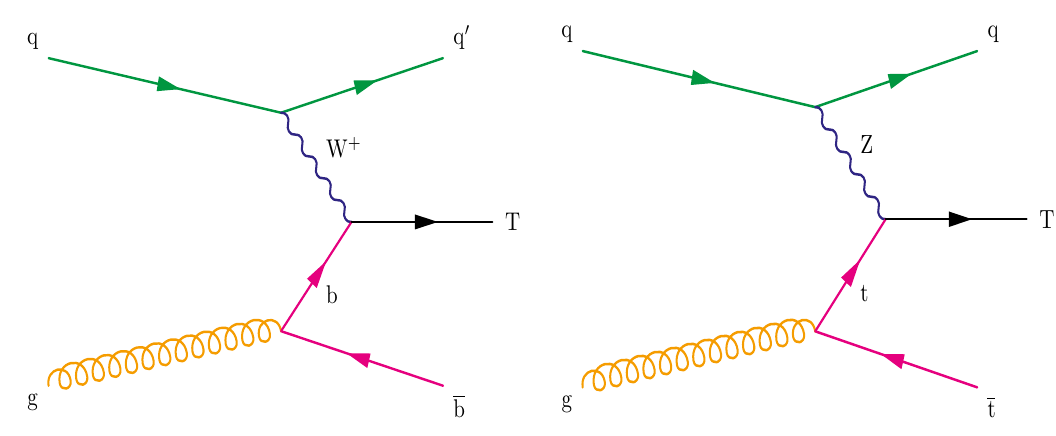
Figure 1 . Example Feynman diagrams for electroweak production of vector-like T quarks. Charged-current (left) and neutral current